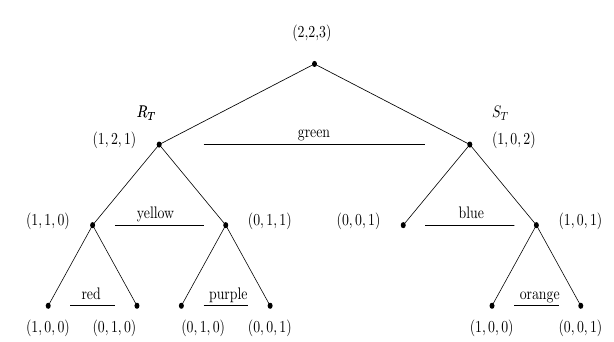
Figure 2: A Huffman labeling for a JL-coloring of K